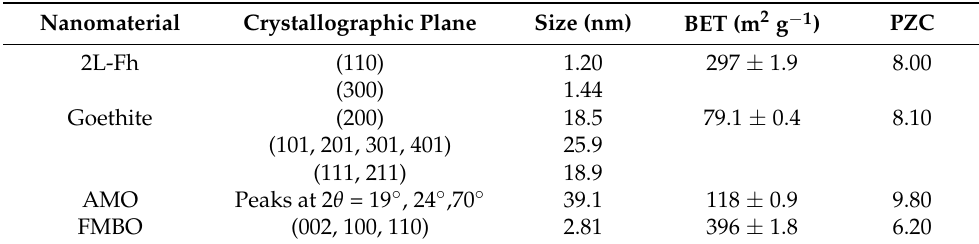
Table 1. Particle size, specific surface-area and point of zero charge a